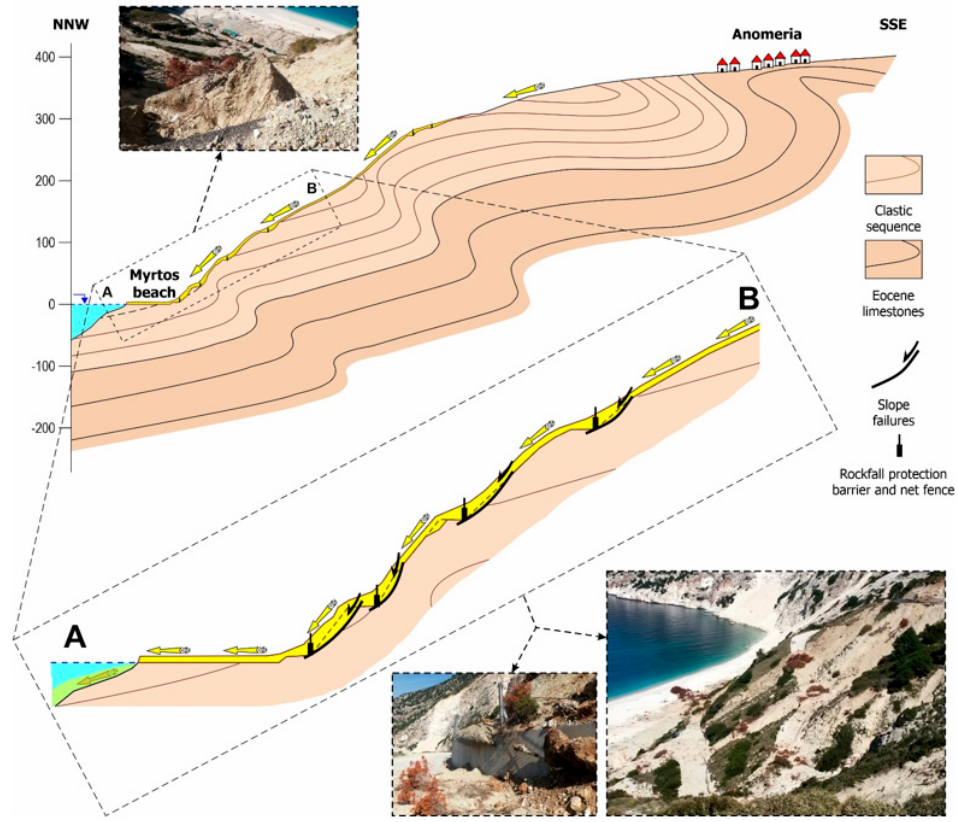
Figure 2. The morphological, geological, tectonic, and geotechnical context of the generation of de ‐ structive slope failures on the steep slopes of the Myrtos coastal area, based on geological field sur ‐ veys in the area.